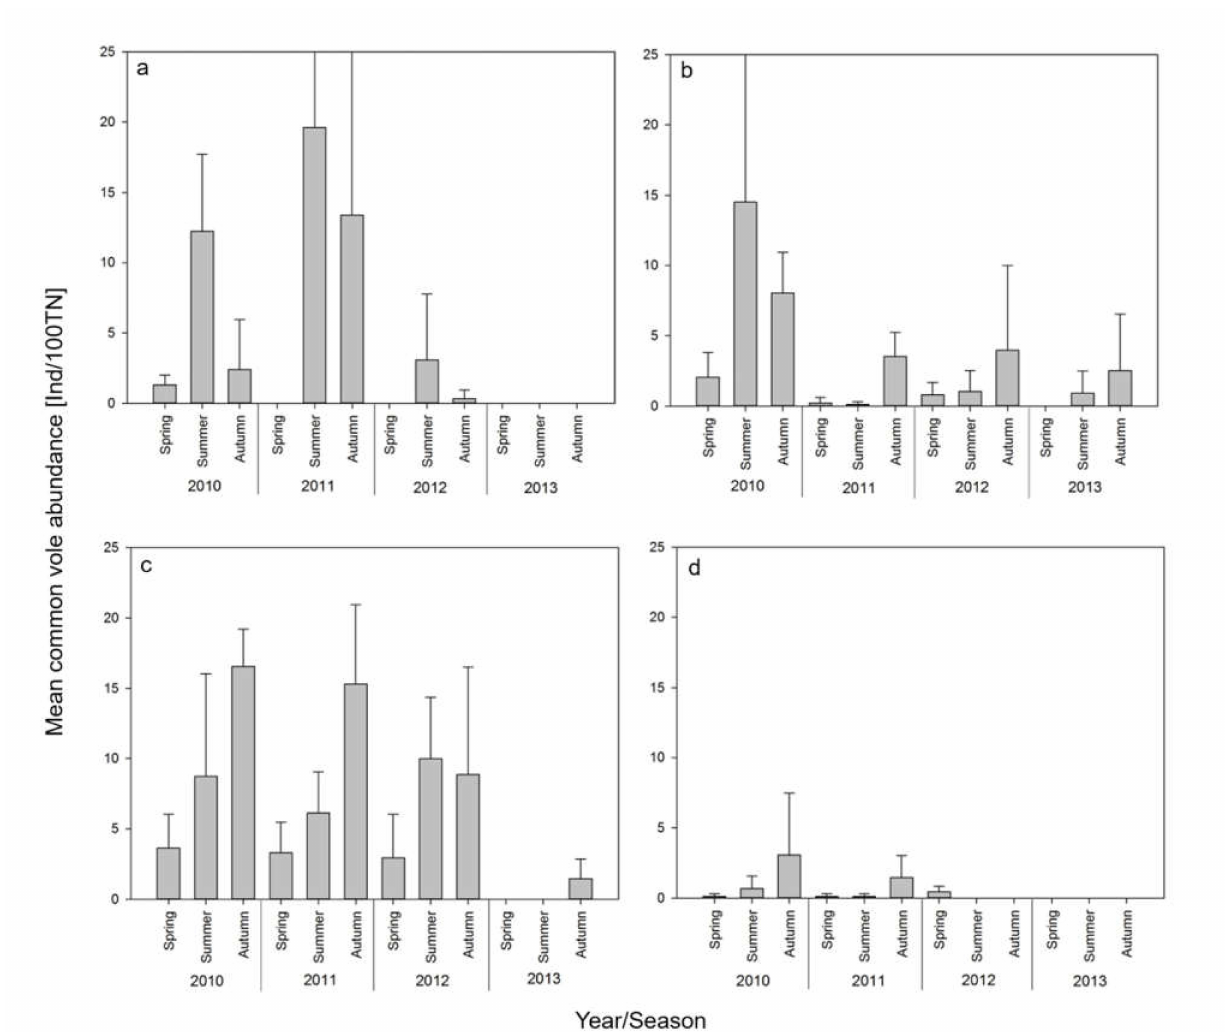
Figure 2. Population dynamics of common voles from 2010 to 2013 in four areas in Germany (( a ): Weissach; ( b ): Jeeser; ( c ): Gotha; ( d ): Billerbeck)). Estimated mean abundance indices ± standard deviation as individuals per 100 trapping nights from three replicate grassland sites per area are based on live and snap trapping (see Table